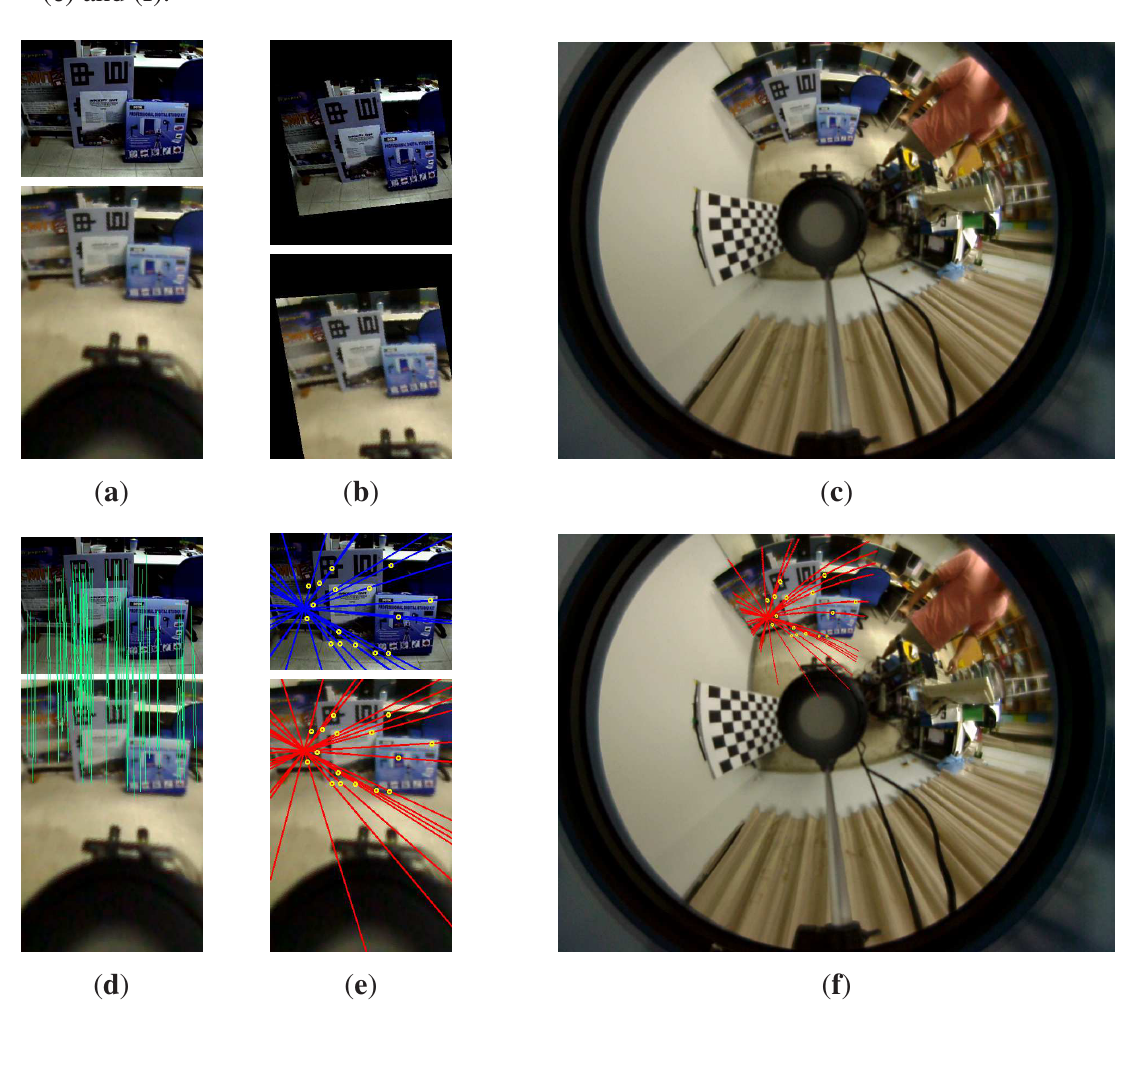
Figure 12. The second experimental result. The captured omnidirectional and perspective images are shown in ( c ) and ( a ) (top). ( a ) (bottom) The generated virtual image. The rectified stereo image pair is shown in ( b ). ( d ) The SIFT correspondences between the perspective and virtual images. The epipolar geometry of the hybrid stereo image pair is illustrated in ( e ) and ( f